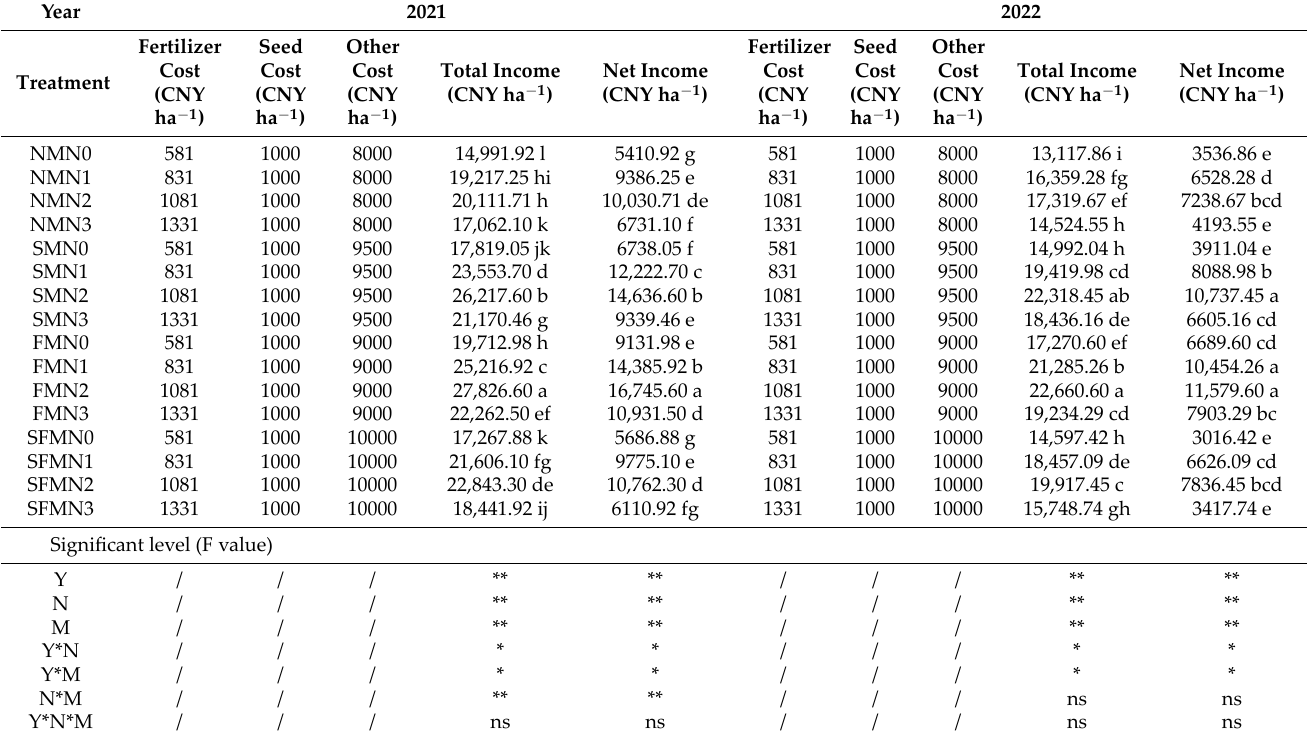
Table 5. Effects of different mulching methods and different nitrogen application on economic ef‑ ficiency. According to the survey, the soybean price was 5 CNY kg